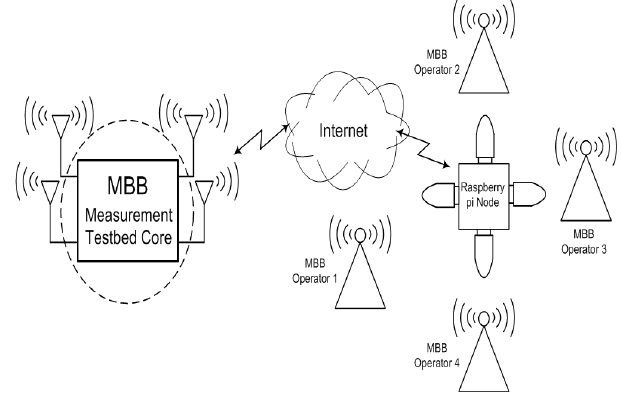
Figure 10. Overview of the Simpli fi ed Raspberry Pi platform [50].